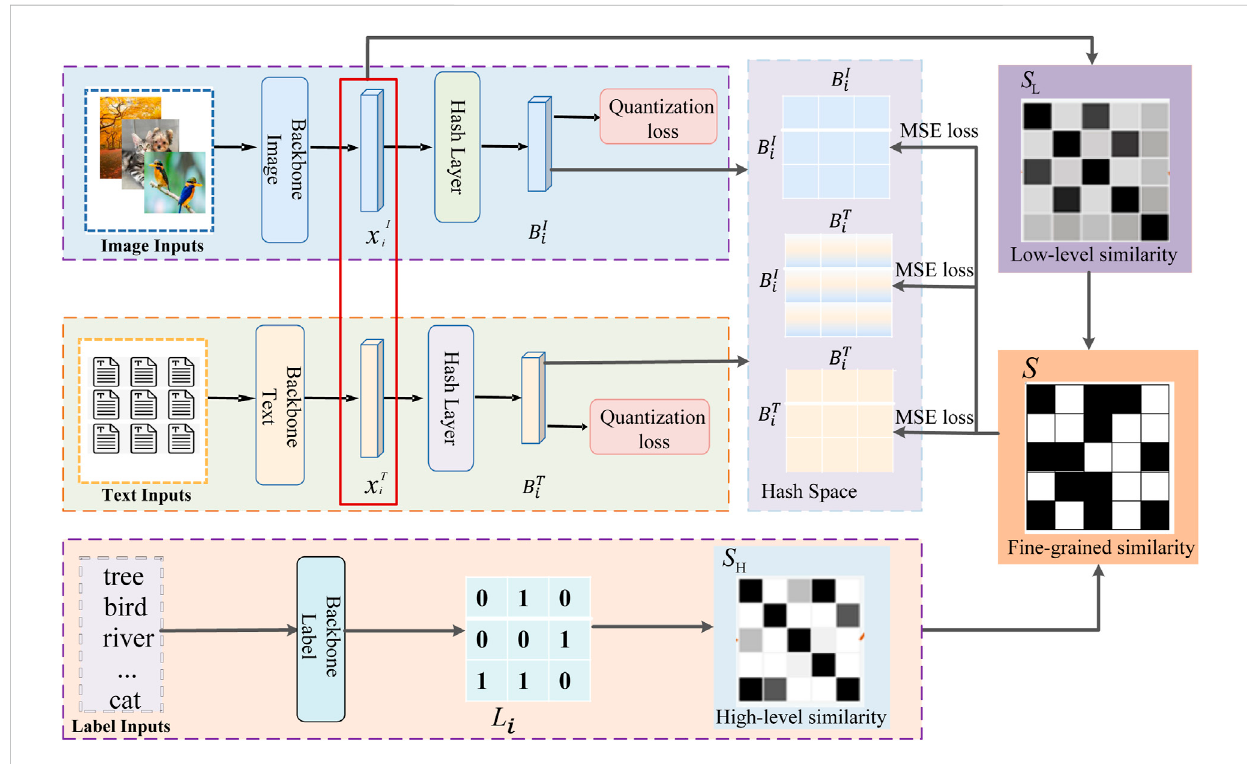
FIGURE 1 The framework of the proposed FSSPDH